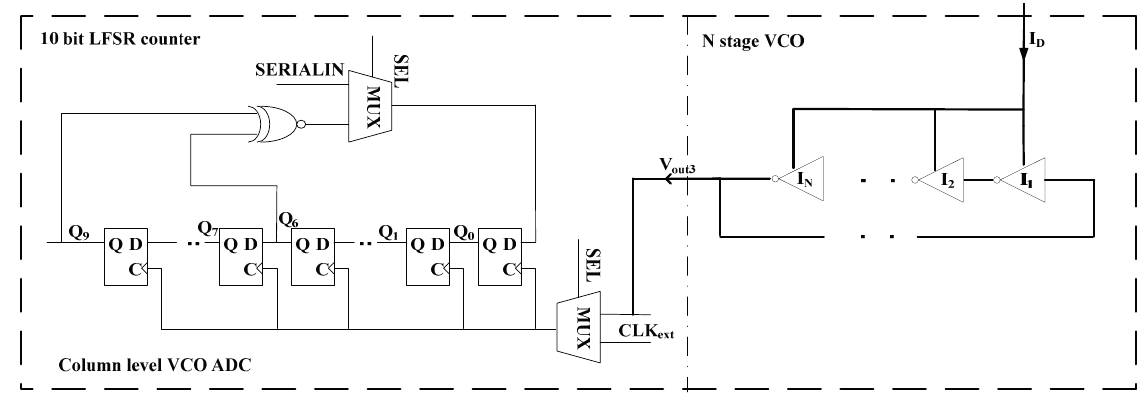
Figure 5. The schematic of the proposed VCO-based